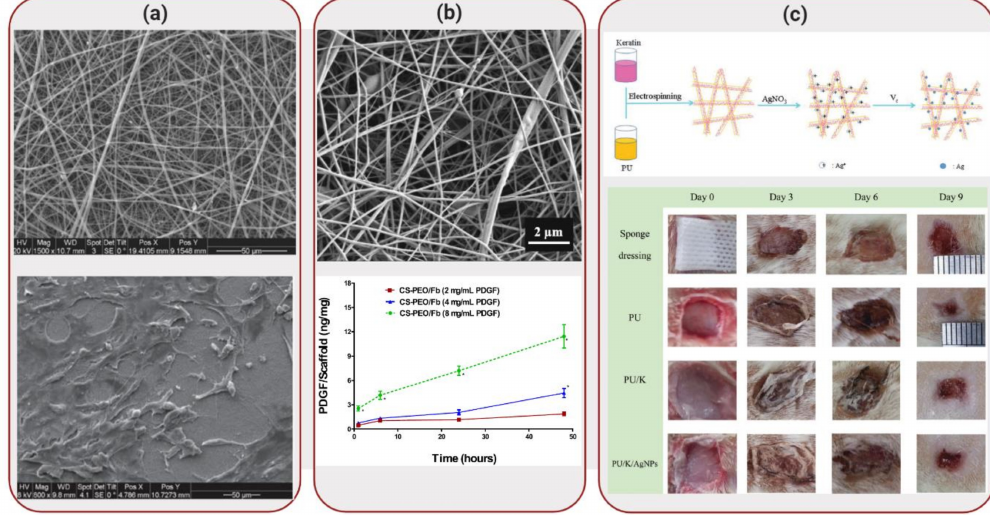
Figure 4. Applications of Biocomposites to Wound Healing: ( a ) SEM images of polycaprolactone-gelatin nanofiber sca ff old (top) and morphology expression of human skin-derived precursor cells (hSKPs) cells on this matrix. Reproduced with permission from Reference [54]. ( b ) SEM image of fibrous sca ff old composed of chitosan, polyethylene oxide, fibrinogen (top). Platelet-derived growth factor (PDGF) was released from the sca ff olds, displaying a dose-dependent profile (bottom). Reprinted with permission from Reference [57]. ( c ) Schematic illustration of fabrication of polyurethane / keratin / silver nanoparticles sca ff old (top). Wound healing tests were performed using di ff erent dressing materials, including a sponge dressing (control), in the back of rats (bottom). Reprinted with permission from Reference